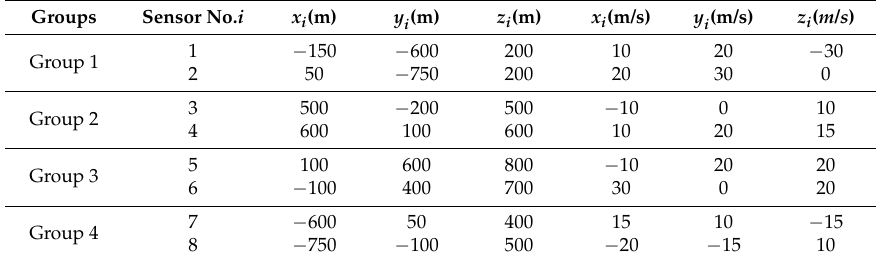
Table 1. Distributed Passive Sensors Configuration.